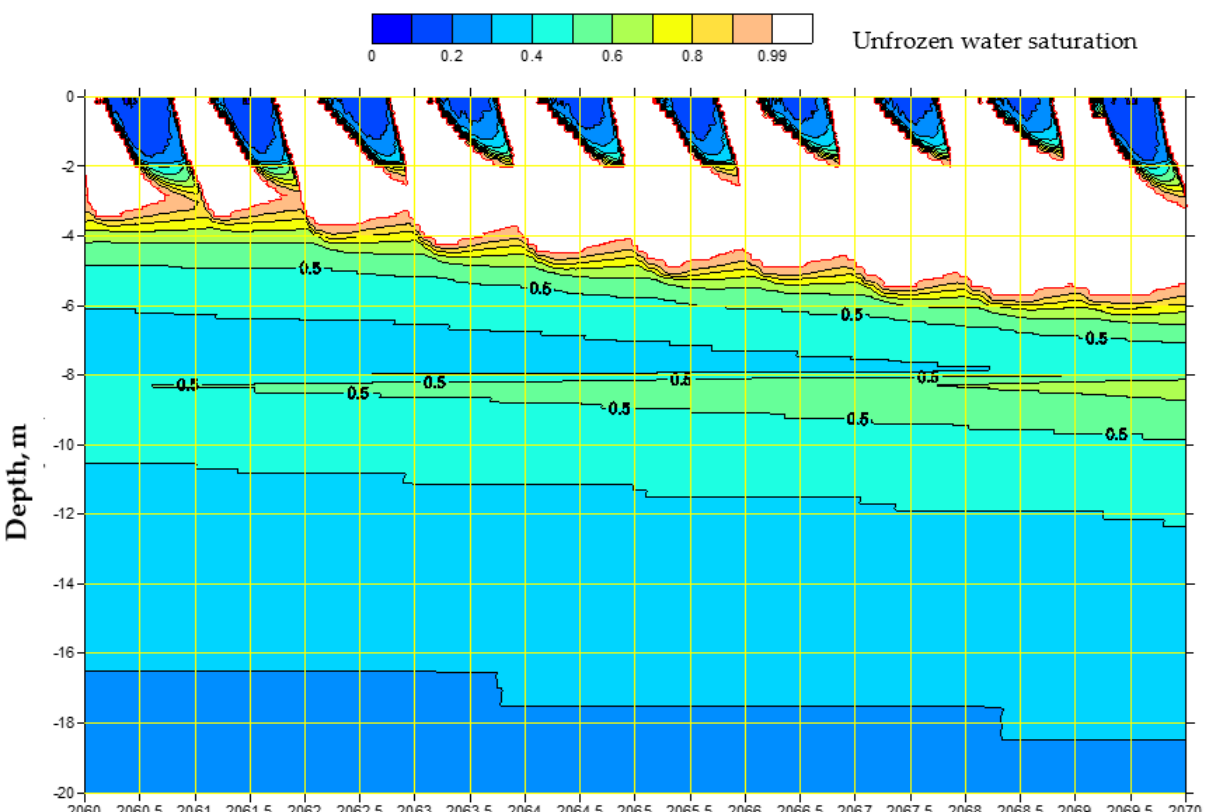
Figure 3. Forecast of the mean annual unfrozen water saturation integrated over 10-m upper layer of the ground: IUWS (blue line) and the permafrost table depth (red line) vs. time (years) for Point “631—Marre-Sale” (Western Yamal), scenario RCP-8.5, undisturbed conditions.